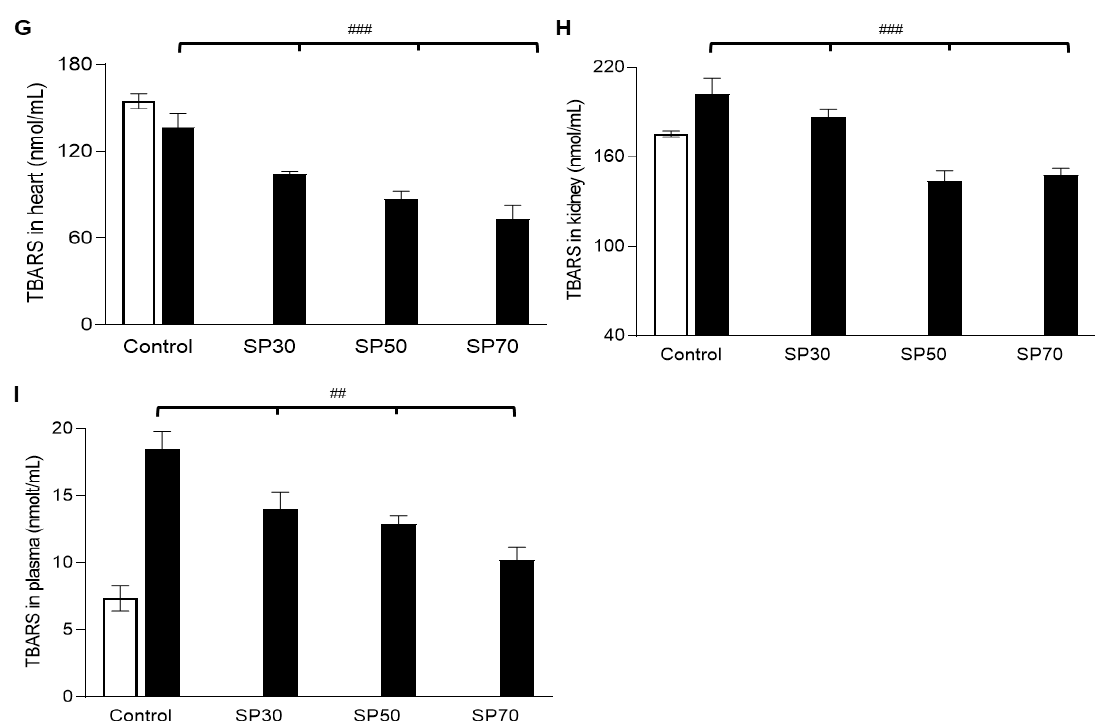
Figure 4. E ff ect of spirulina on antioxidant activities and lipid peroxidation. ( A ) quinone reductase (QR) in liver, ( B ) glutathione (GSH) in liver, ( C ) GSH in plasma, ( D ) glutathione S -transferase (GST) in liver, ( E ) glutathione reductase (GR) in liver, ( F ) thiobar–bituric acid reactive substance (TBARS) in liver, ( G ) TBARS in heart, ( H ) TBARS in kidney, and ( I ) TBARS in plasma were measured in growing male rats fed with control, SP30, SP50, and SP70 diet over the 7-week course of the study. Data are mean ± SEM values. Significant di ff erences were determined using one-way ANOVA with post hoc Duncan’s multiple-range test comparisons. # p < 0.05, ## p < 0.01, or ### p < 0.001 between groups in the same week. Control: AIN 93G diet; SP30: 30% of protein source replaced with spirulina; SP50: 50% of protein source replaced with spirulina; SP70: 70% of protein source replaced with spirulina. The week of the treatment is represented by O: 0 weeks; ■ : 3 weeks; ▲ : 7 weeks in each group. White bar: 0 weeks; black bar: 7 weeks.